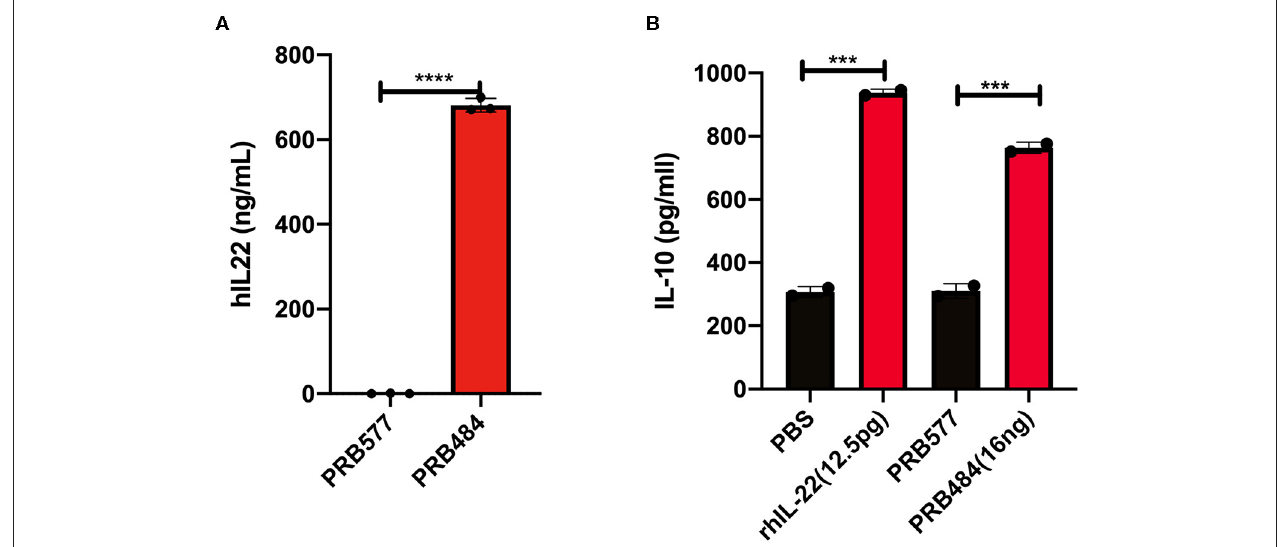
FIGURE 1 | Expression and secretion of hIL-22 by L. reuteri . (A) Recombinant hIL-22 detected by ELISA in supernatants of recombinant L. reuteri (PRB484) upon induction. L. reuteri expressing pSIP411 was used as control (PRB577). (B) Induction of IL-10 production from Colo205 cells upon treatment with commercial rhIL-22 as compared to bacterially secreted IL-22. Data are mean of n = 3 with error bars representing deviation from the mean; comparisons performed with t -tests (two groups) or analysis of variance (ANOVA) (multiple groups). *** P < 0.001, **** P < 0.0001.